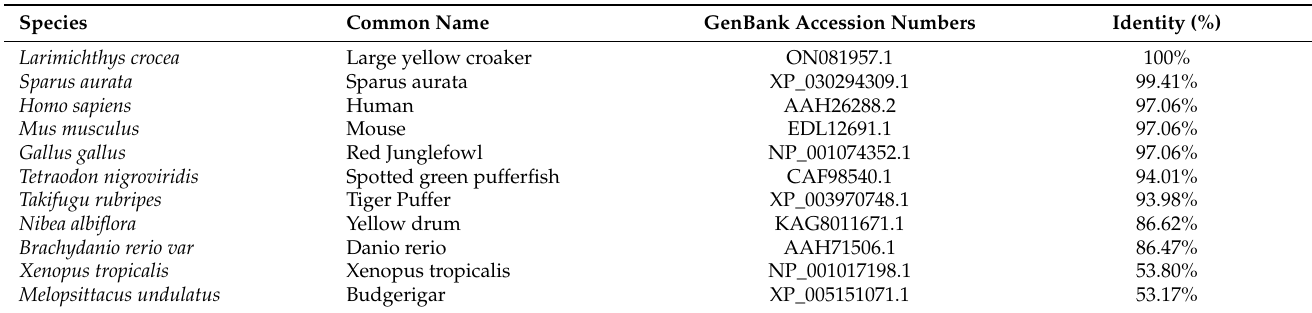
Table 1. Identity analysis of amino acid sequences of Ube2g1 in Larimichthys crocea and other species.